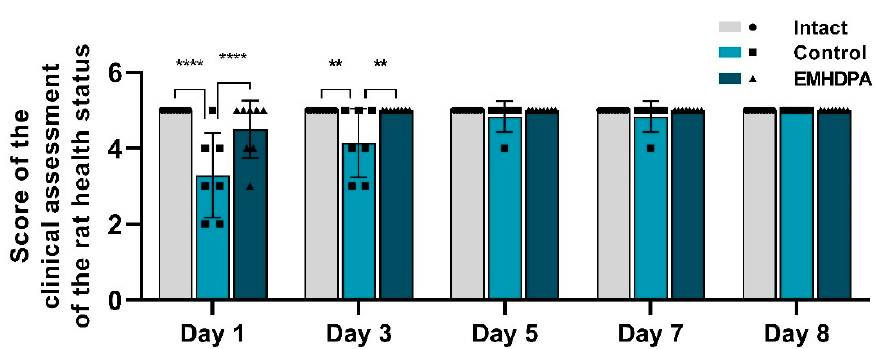
Figure 2. Dynamics of the clinical assessment of health status in the studied groups (by the average score in the group). Note: **— p < 0.01; ****— p < 0.0001; 1—intact group; 2—control group; 3—group administered with EMHDPA 25 mg/kg.